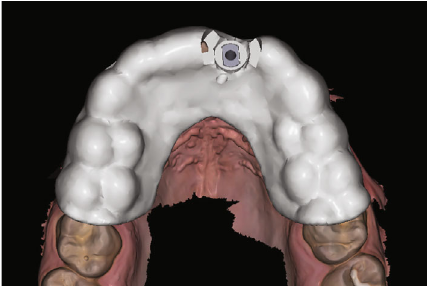
Figure 4: CAD surgical template based on the intraoral scan and the implant planning.